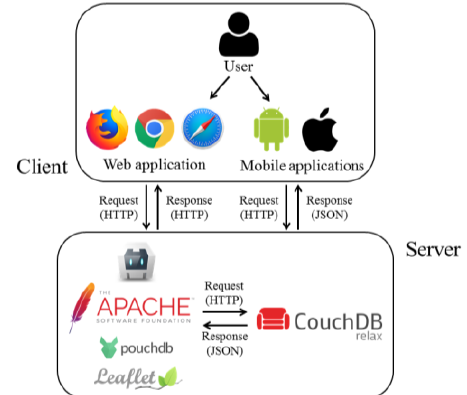
Figure 8. Architecture of the Land Cover Collector application.